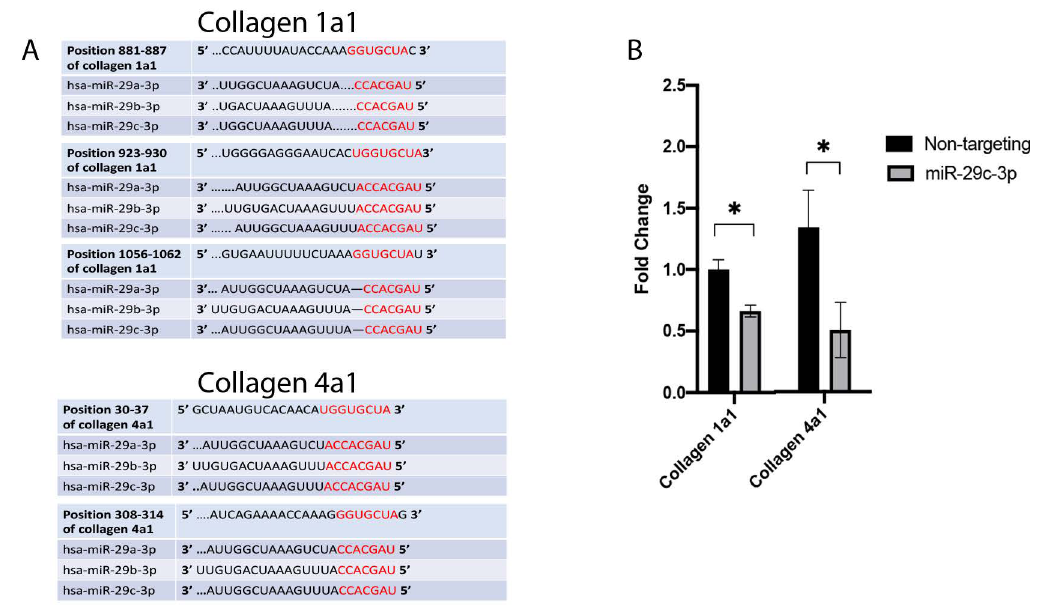
Figure 4. Collagens as prominent targets of the miR-29 family. ( A ) The TargetScan database was used to identify the 3 (cid:48) -UTRs of collagen 1a1 and collagen 4a1 as predicted binding sites for miR-29 family members (red). ( B ) Primary human LC cells were transfected with miR-29c-3p mimic (10 nm) or non-targeting control (10 nm). Expression of collagens type 1a1 and 4a1 were analyzed by qPCR. GAPDH was used as an internal control for normalization (* p <